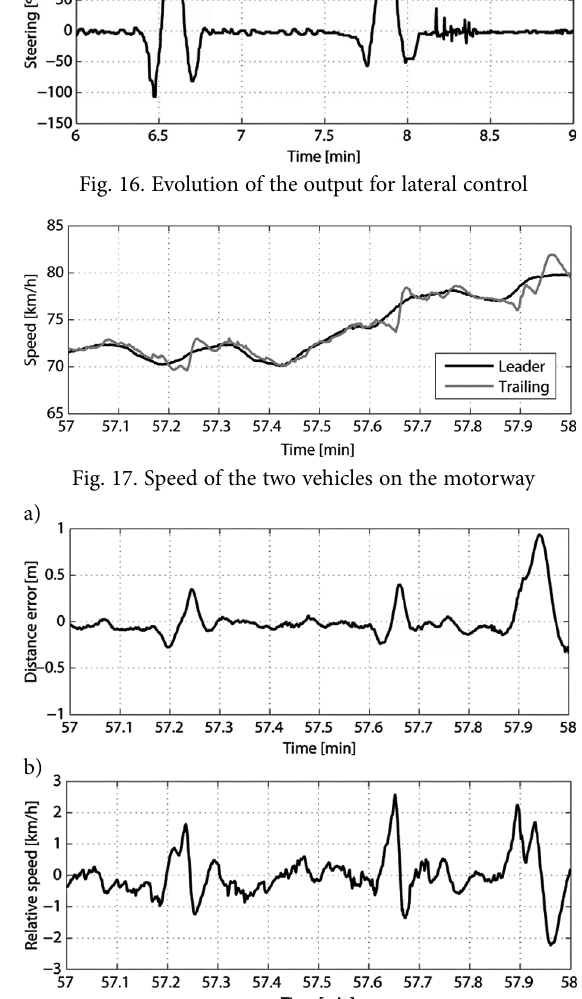
Fig. 18. Evolution of the input variables for longitudinal control in the motorway scenario: a – distance error; b – relative speed